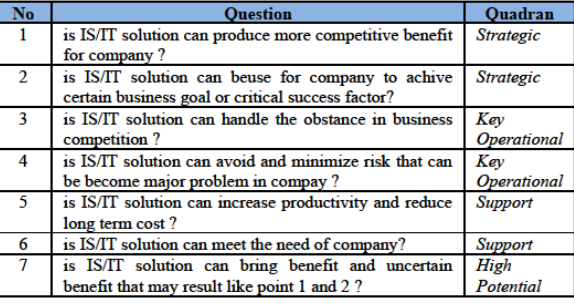
Figure 14: Question for Determine McFarlan Grid